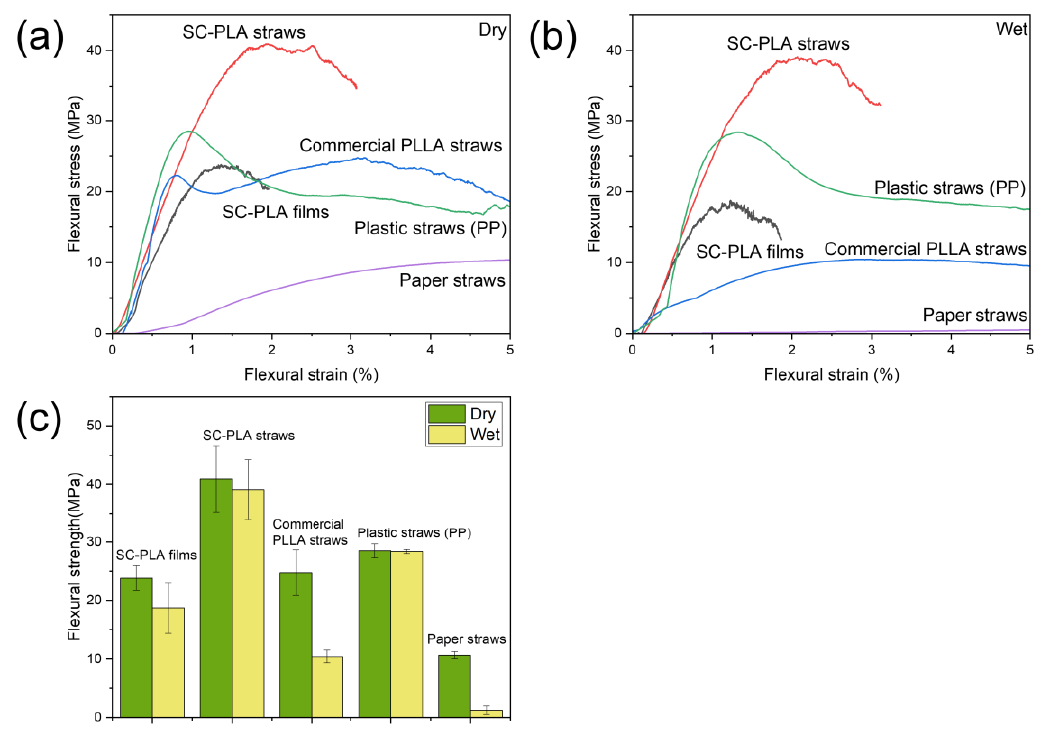
Figure 5. ( a ) Typical flexural stress-strain curves for all straws. ( b ) Typical wet flexural stress-strain curves for all straws immersed in hot water at 100 °C for 10 min. ( c ) Comparison of flexural strength of straws in different states. Table 3. Comparison of average flexural strength and loss of flexural strength of straws exposed to 100 °C hot water for 10 min.